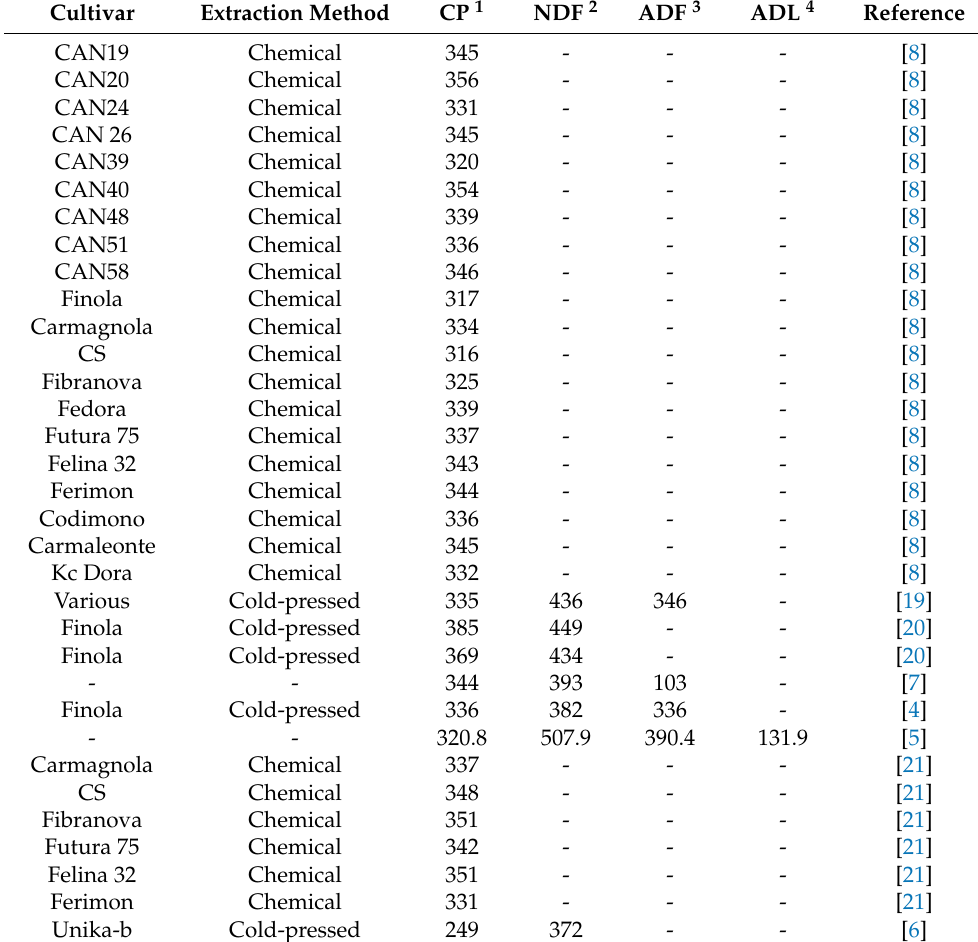
Table 5. Nutritive value parameters of hempseed meal samples from published